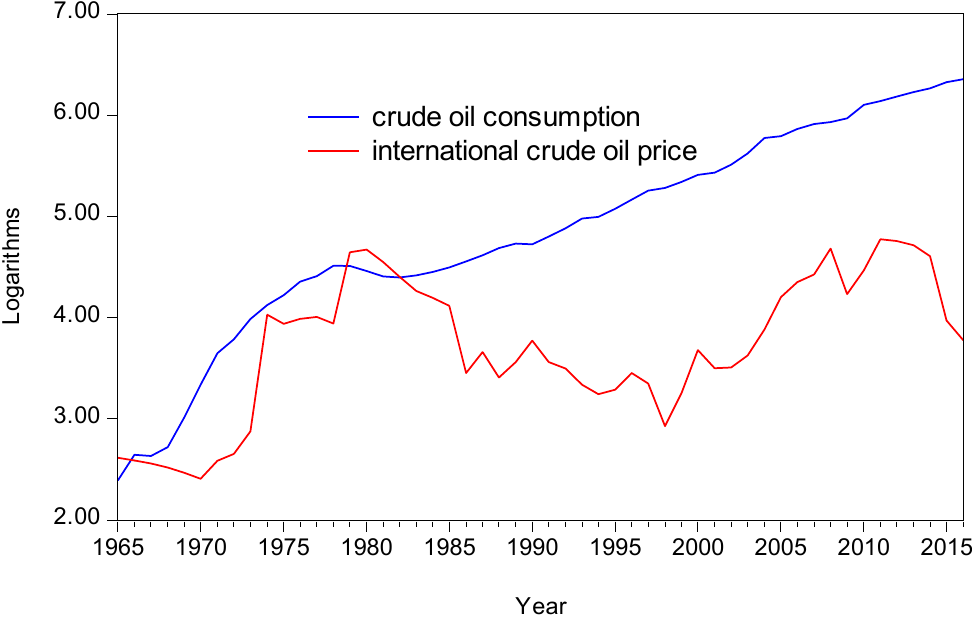
Figure 1. Change in crude oil price and consumption in China.